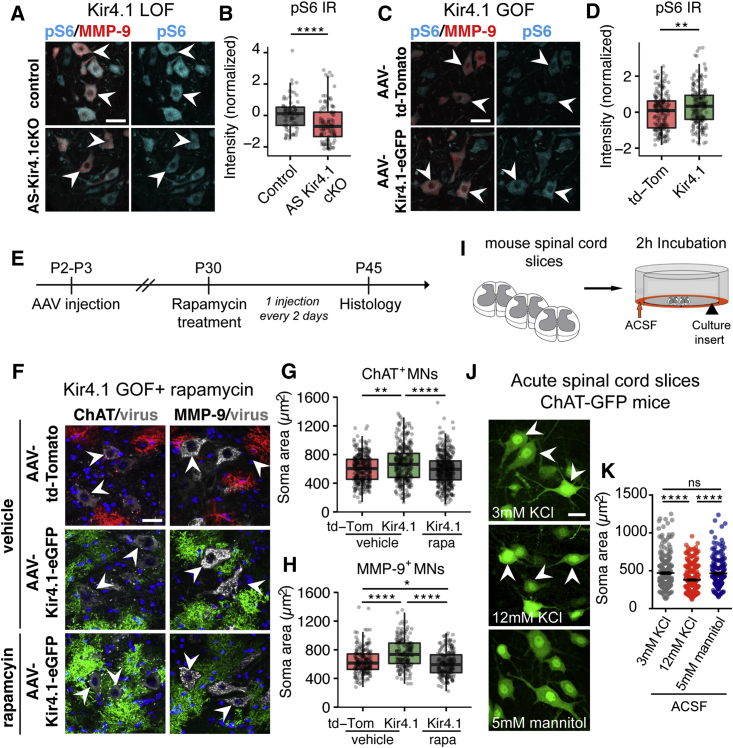
AS Kir4.1 Regulates MN Size through PI3K/mTOR/pS6 Pathway(A and C) Immunofluorescence co-staining of mTOR downstream effector pS6 and MMP-9+ MNs in P30 AS-Kir4.1cKO LOF mice (A) and in P60 AAV-Kir4.1 GOF mice (C).(B and D) Quantification of pS6 fluorescence intensity per MMP-9+ MN (B, LOF: n = 3 mice/group, 80 MNs counts/animal; D, GOF: n = 5 mice/group, 200 MN counts/animal, boxplot, Mann-Whitney test, scale bar, 25 μm).(E) Rapamycin treatment in AAV-Kir4.1 GOF mice.(F) Immunofluorescent co-staining of ChAT (left) and MMP-9 (right) in vehicle-treated AAV-td-Tomato and AAV-Kir4.1-eGFP mice (top two panels) or rapamycin-treated AAV-Kir4.1-eGFP mice (lower panel).(G and H) Quantification of ChAT+ (G) and MMP-9+ (H) MN size in vehicle-treated AAV-td-Tomato and AAV-Kir4.1-eGFP and rapamycin-treated AAV-Kir4.1-eGFP mice (n = 3–4 mice/group, 100 MN counts/animal, boxplot, Kruskal-Wallis test, scale bar, 30 μm).(I) Incubation of acute spinal cord slices in solutions with high K+ concentration.(J) Detection of ChAT-GFP+ MNs in the ventral horn of P14 mice after 2 hr incubation in 3 mM KCl, 12 mM KCl, or 5 mM mannitol ACSF.(K) Quantification of MN soma area in the corresponding conditions (n = 4 mice/group, average 250 MN counts/animal, mean ± SEM, Kruskal-Wallis test, scale bar, 25 μm).